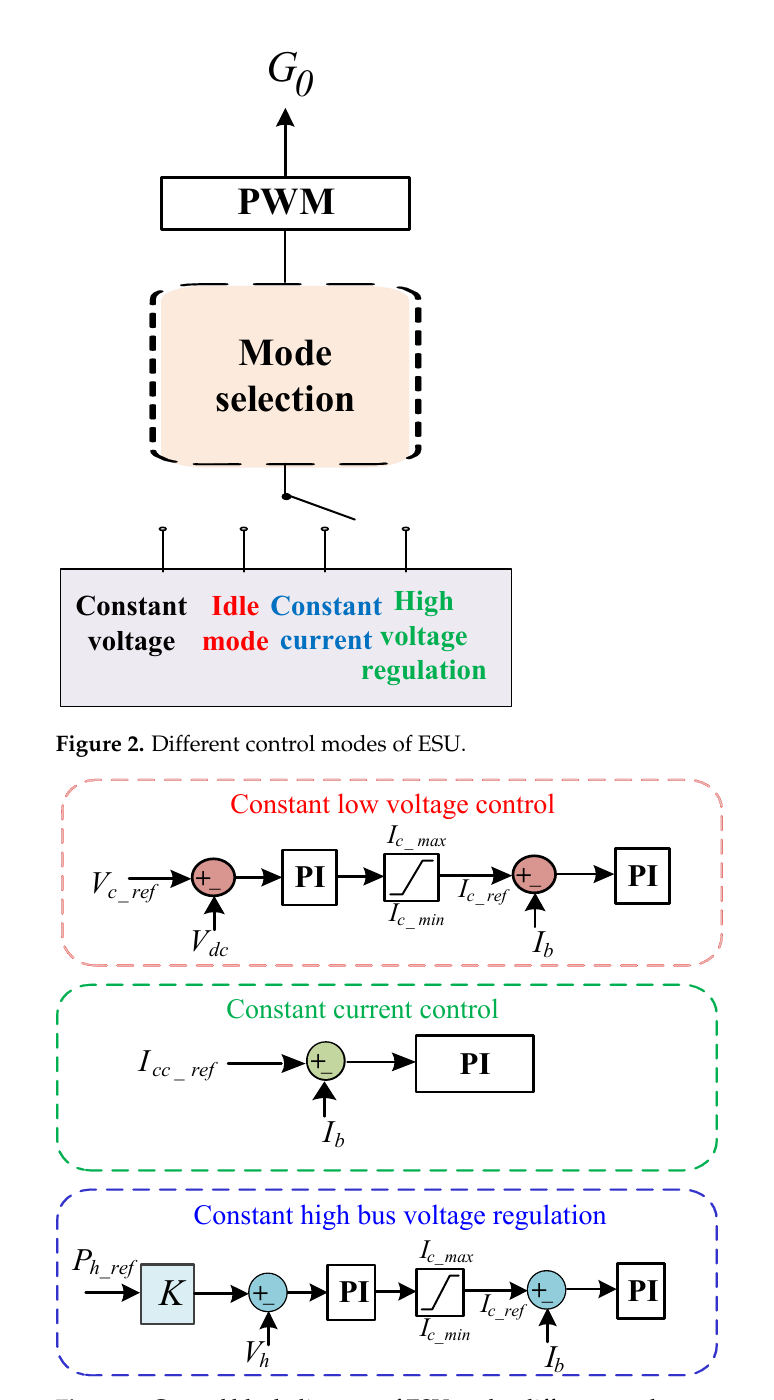
Figure 3. Control block diagram of ESU under different